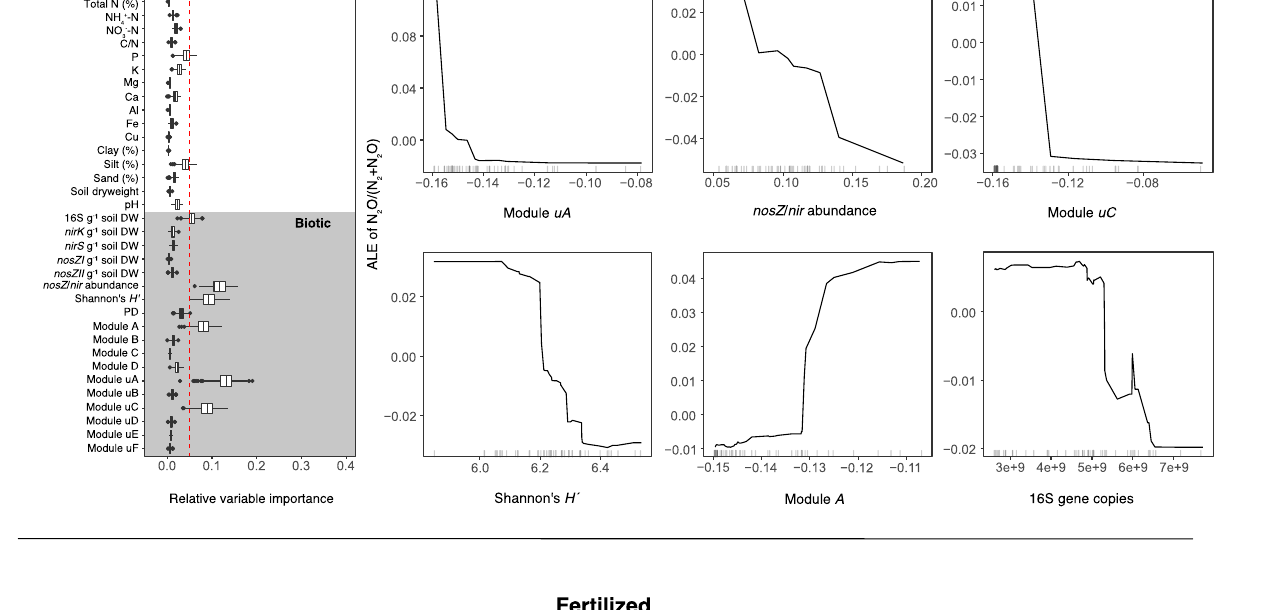
homogenised by sieving through a 4mm mesh. A subsample was used for a physico – chemical analysis (Agrilab AB, Uppsala, Sweden; Supplementary Table 2), and the rest stored at − 20°C for later processing. Potential denitri fi cation and N 2 O production . For each sample, two portions of 10 g fresh weight soil were each weighed into 125 mL Duran bottles and made into slurries by adding 20 mL distilled water. The bottles were capped and the head- space exchanged by fl ushing with N 2 . For each sample, potential denitri fi cation was measured in one bottle by injecting acetylene to reach a partial pressure of 0.1atm,